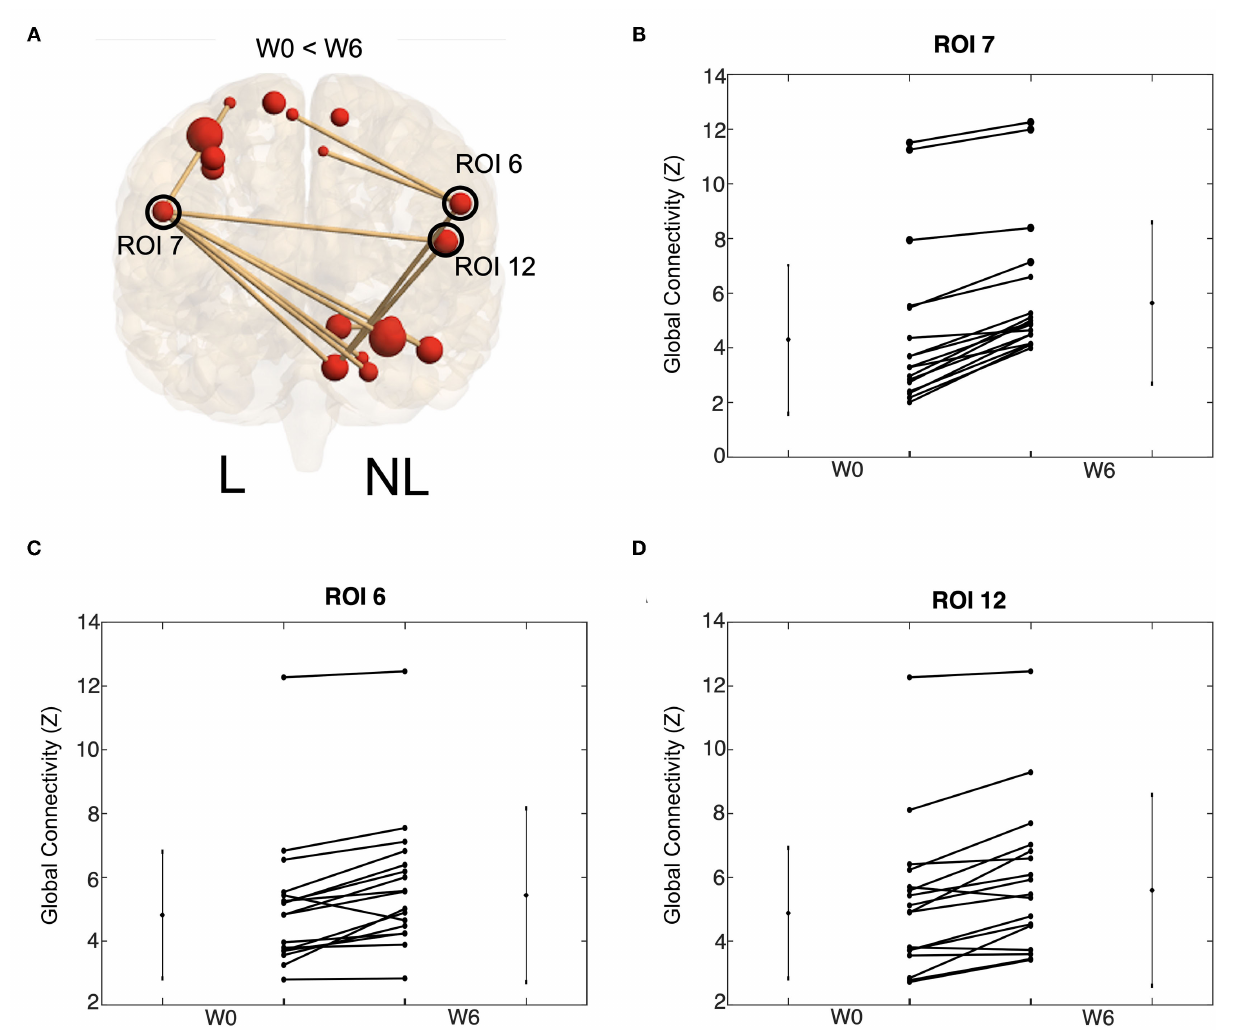
FIGURE 7 | Increases tend in functional connectivity following BoNT-A injection therapy. Global connectivity strength for all task ROIs connected to ROI 7, 6, and 12. Visual depiction of these ROI (A) . The size of the red ball represents the size of the ROI and the thickness of the line references the Z-transformed correlation coefficient size. Only significant connections are visualized. Trends of ROI 7 (B) , ROI 6 (C) , and ROI 12 (D) are shown. These trends are for all task ROI connections to the given ROI; each line represents group average for one connection. Values are shown for W0 and W6 with a line connecting values of the same connection strength. Lines on the side of the graph show the mean and standard deviation of the connection strength across stroke